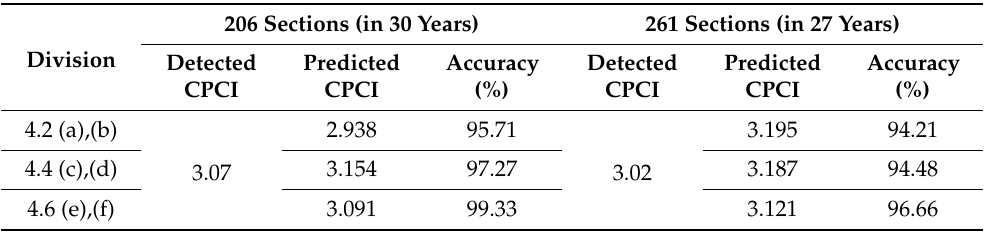
Table 2. Comparison of prediction accuracy for each section according to changes in initial CPCI (4.2, 4.4, and 4.6).